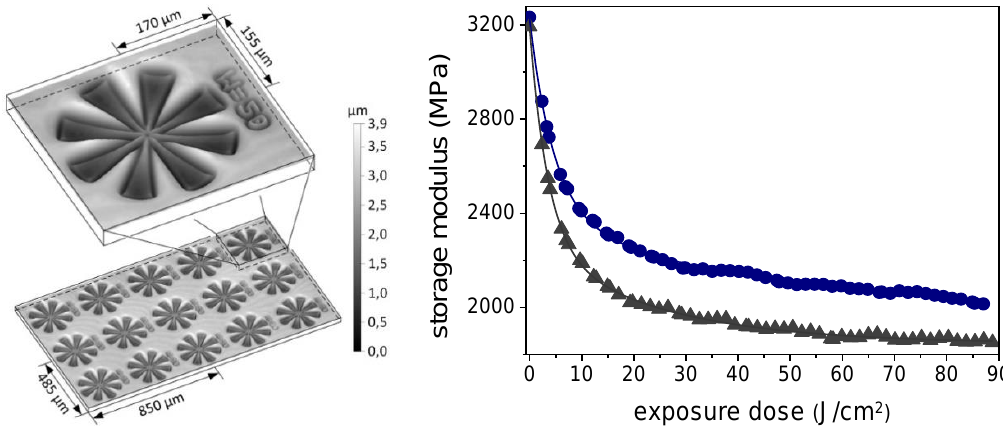
Figure 16. Positive-type photoresists and storage modulus variation of epoxy-NBE network upon UV exposure (Reprinted from reference [124] with the permission of Elsevier).